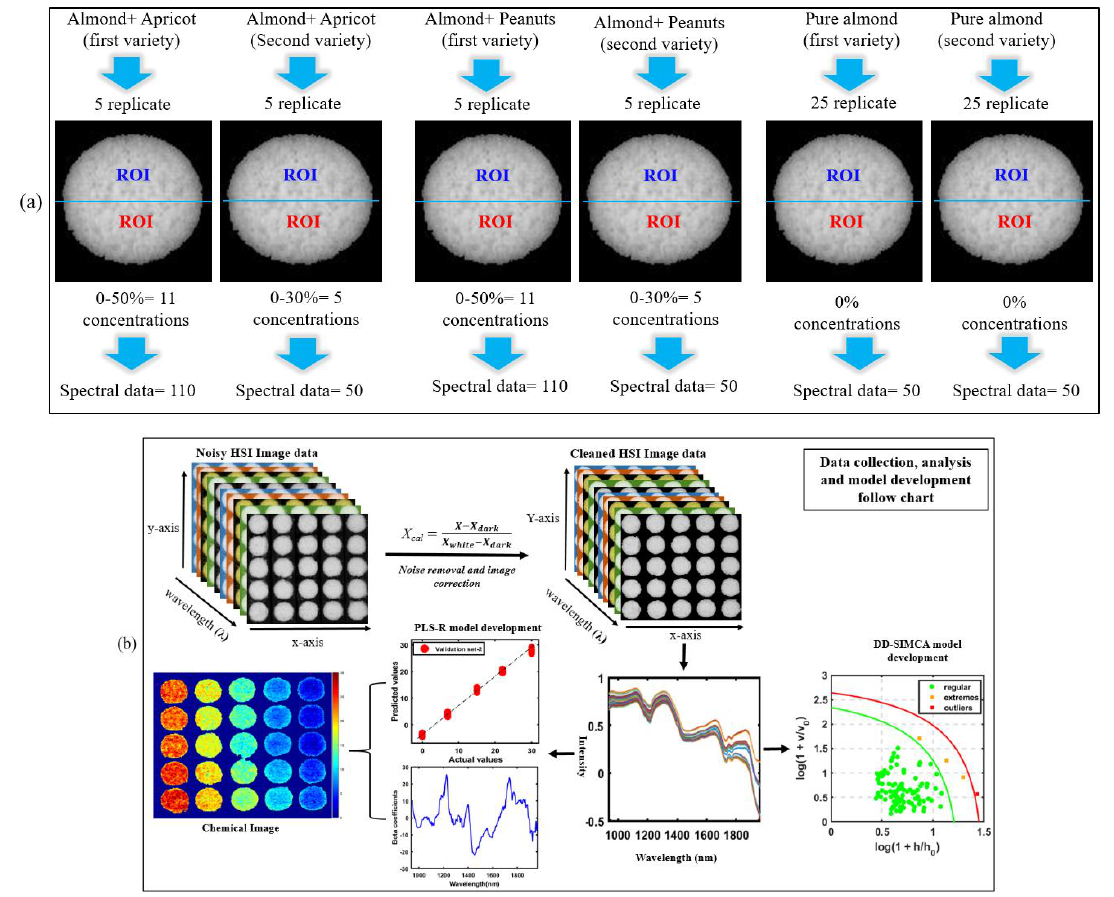
Figure 2. ( a ) Spectral data division and extraction process from the region of interest (ROI) of the samples and ( b ) flow chart of hyperspectral image correction and data analysis.